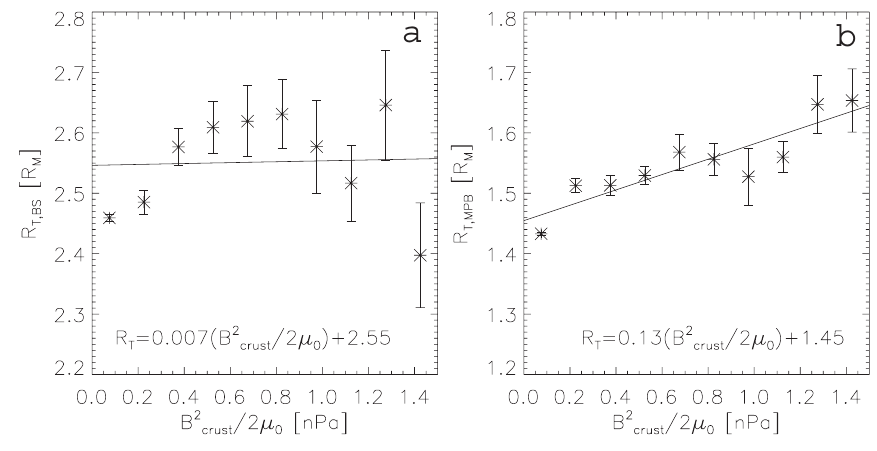
Fig. 9. Extrapolated terminator distance of all the (a) BS and (b) MPB crossings observed by MEX from February 2004 until January 2009 plotted as a function of the magnetic pressure from the crustal magnetic field as calculated from the model by Cain et al. (2003). The solid lines are fitted curves to the data points and the error bars show standard error on the mean